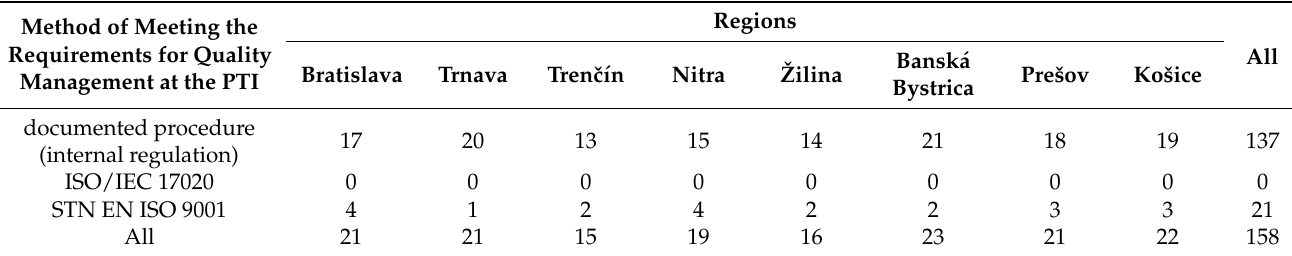
Table 1. Numbers of PTIs in individual regions of the Slovak Republic based on the fulfilment of quality management requirements.